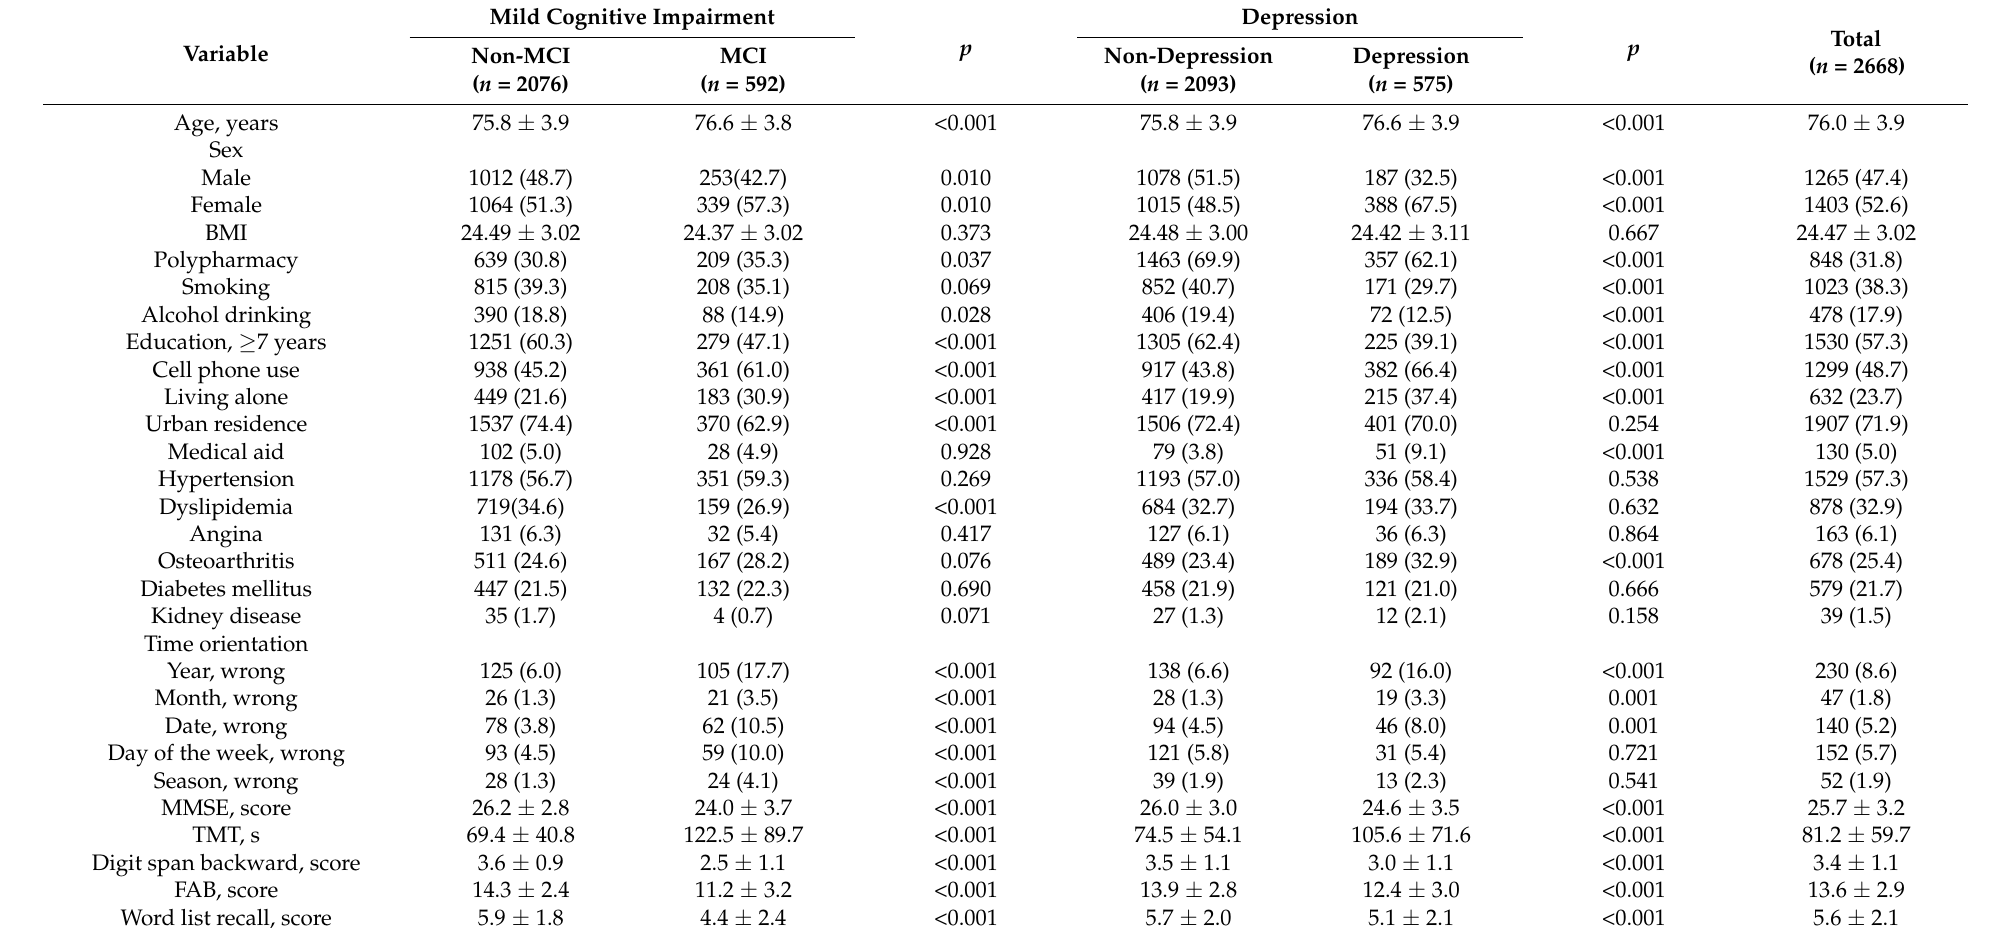
Table 1. Baseline characteristics of the study subjects according to mild cognitive impairment or